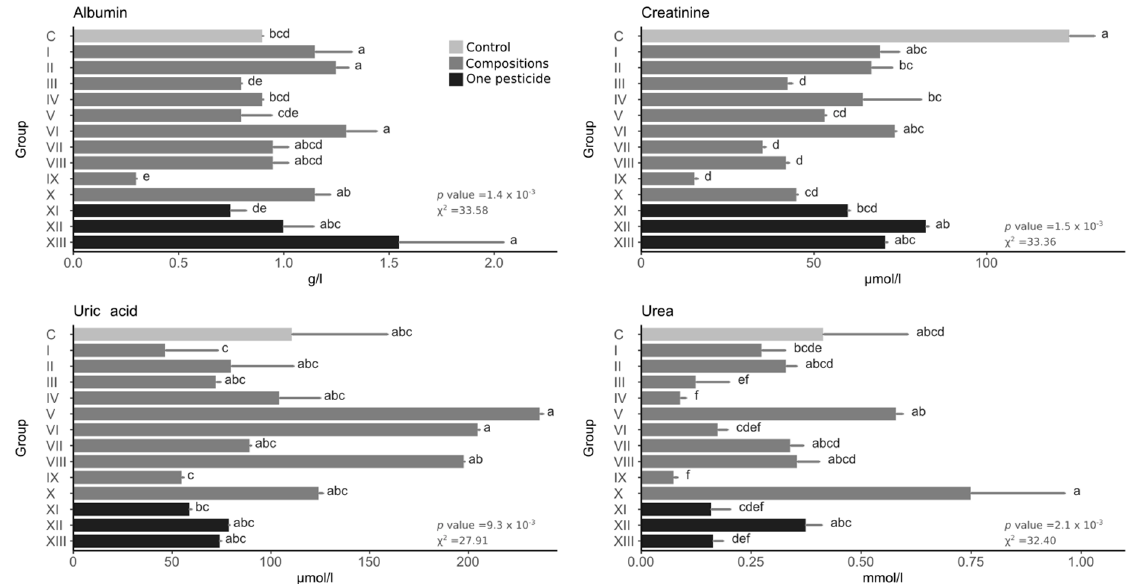
Figure 4. Detoxification system indicators. Bars represent the mean, and error bars represent the standard deviation. The same letters between groups within one plot mean no statistically significant differences (Kruskal–Wallis test with holm correction for multiple comparisons, α = 0.05); the statistical values are shown in the lower right corner of each graph.